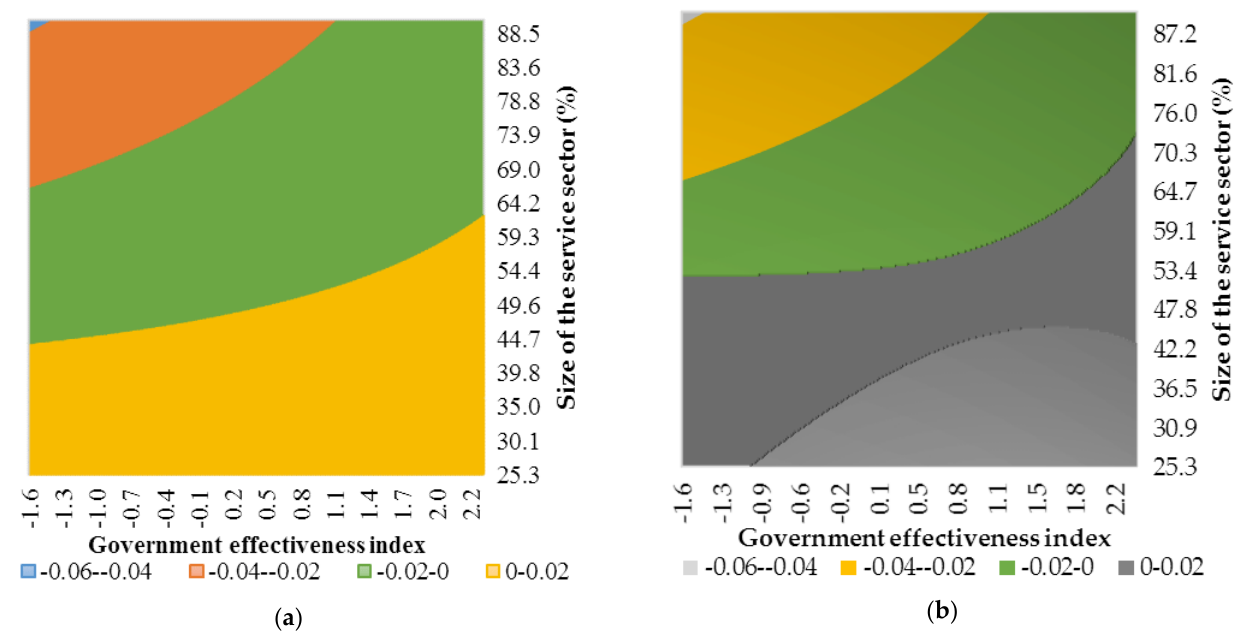
Figure A14. Conditional effect of financialisation on growth based on Est. 14 in Table A2. ( a ) Estimated conditional slope coefficient over the whole range of observed values for institutional quality and development level. ( b ) Estimated statistically significant conditional slope coefficient. Dark gray represents a combination of institutional quality and development level for which effect of financialisation on growth is statistically insignificant. Source: authors’ contributions.